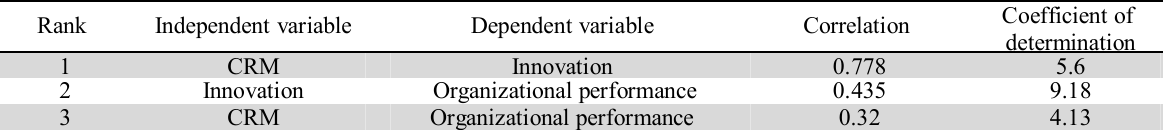
The summary of ranking various factors